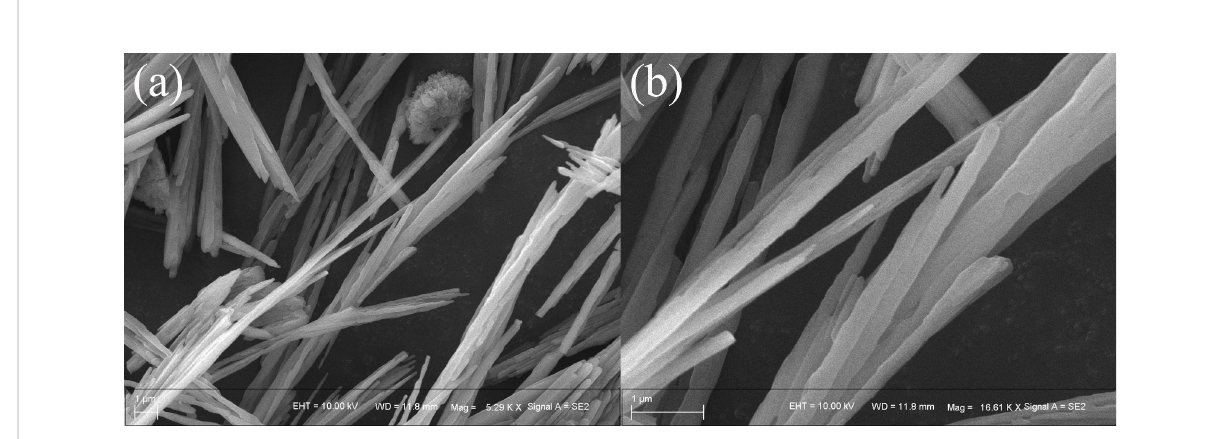
FIGURE 5 SEM images of BPS. SEM image magni fi ed 1,000 times (A) and 5,000 times (B)